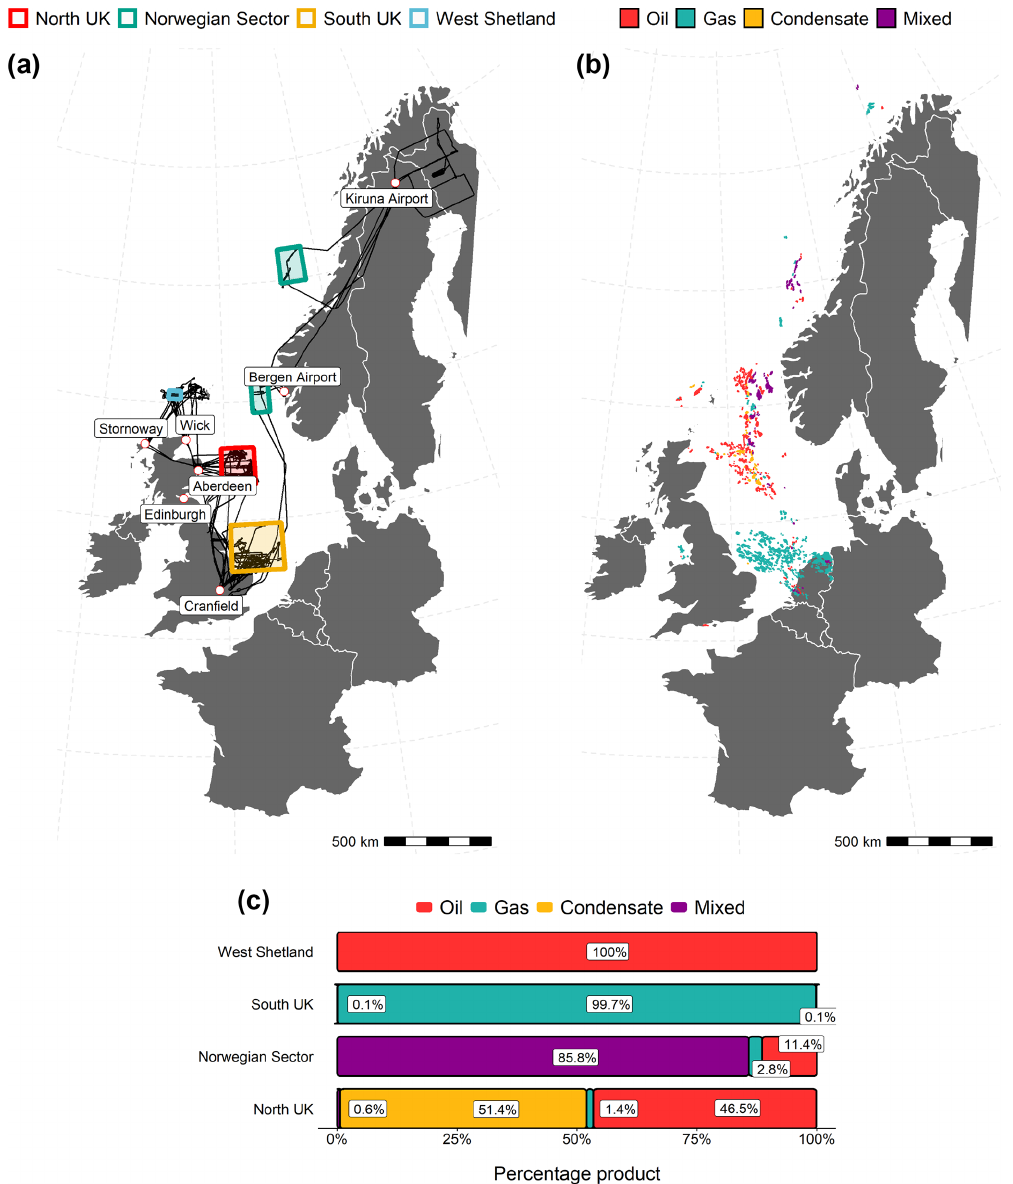
Figure 1. (a) Regions of the North Sea defined for analysis. The black lines represent the flight tracks of the research aircraft. (b) Location of all offshore fields in the North Sea. Each polygon is coloured by the extraction product from each field. (c) Percentage contribution of each offshore field type to the total area of all fields in each region. Country polygons were obtained using the “rnaturalearth” R package (South,